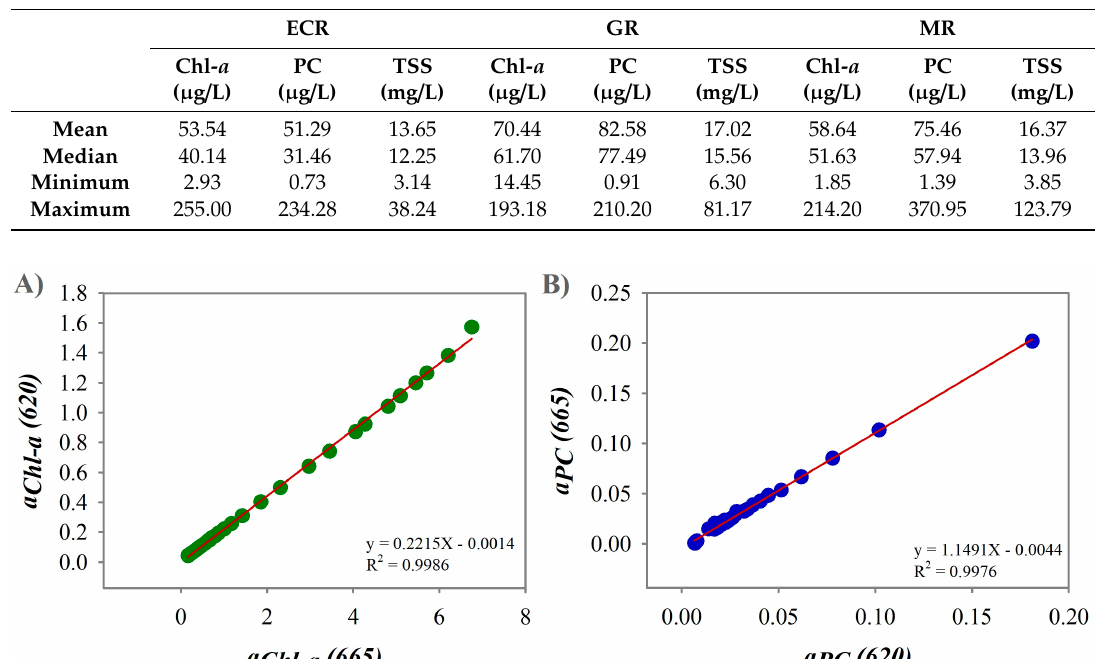
Table 3. Coe ffi cients of Determination for semi-empirical PC estimation algorithms calibrated on the 2005–2007 datasets. Best performances are highlighted in